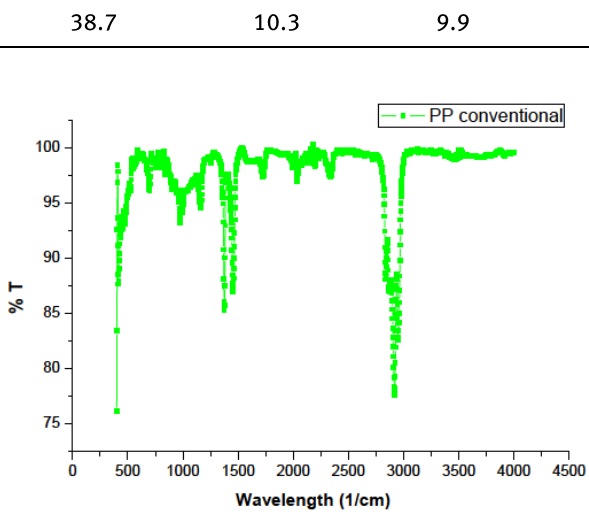
Figure 7: FTIR Plot of PP Conventional cut sample